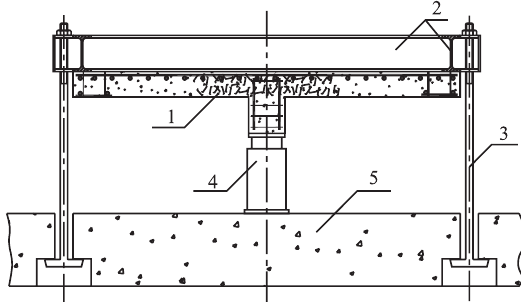
Fig. 4. Diagrams for determination of principle stress action area in the compression zone